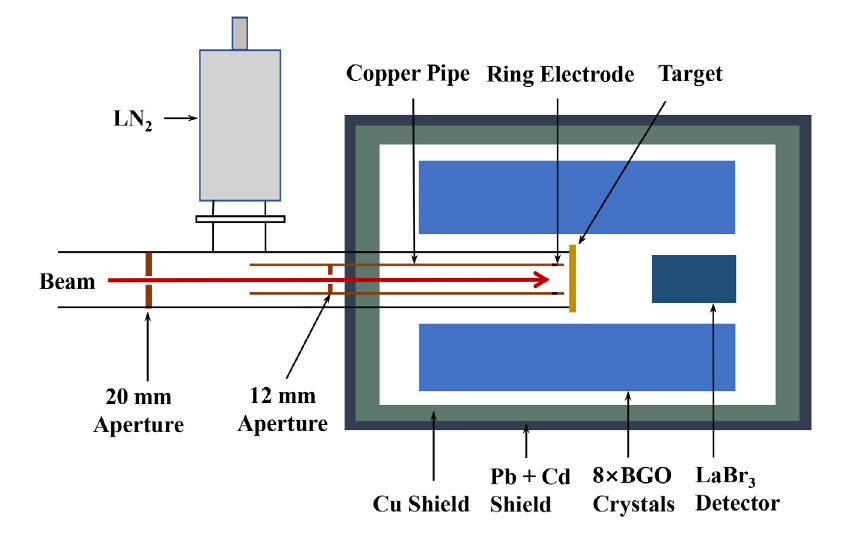
Figure 1: Schematic view of the experimental